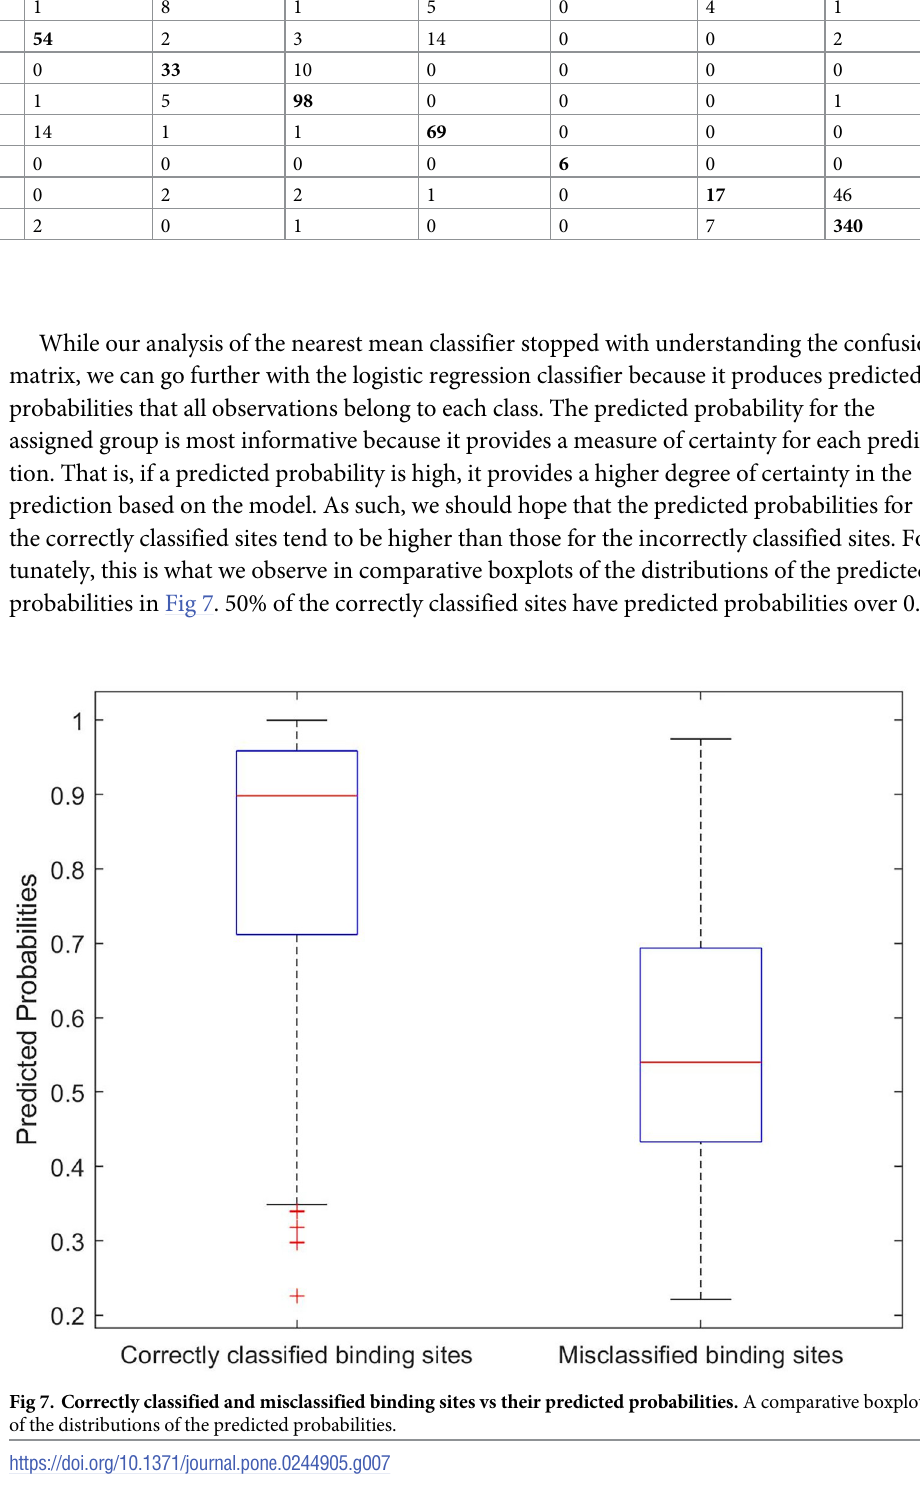
PLOS ONE | https://doi.org/10.1371/journal.pone.0244905 April 8,